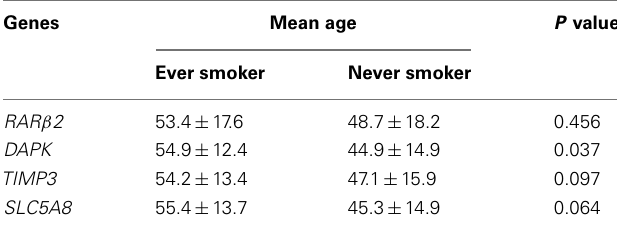
Table 1 | Comparison of mean ages of methylation-positive patients for the indicated genes between the ever-smoker and never-smoker groups.